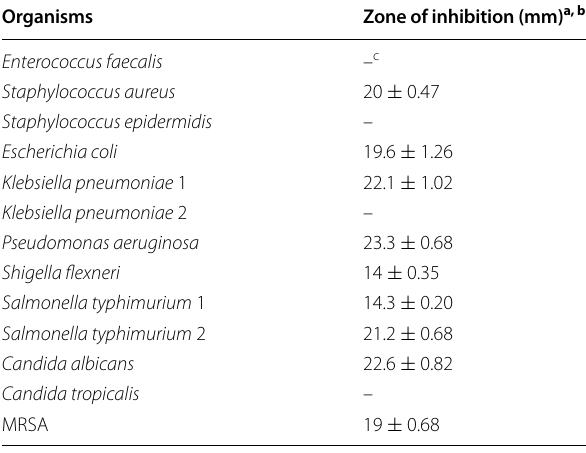
a The Values are expressed as Mean b No significant difference was observed within rows at 5% significance level as revealed by One-Way